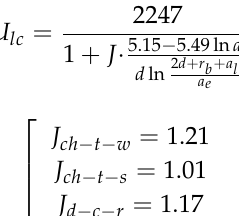
Figure 8. Gap characteristic factors of different gaps.